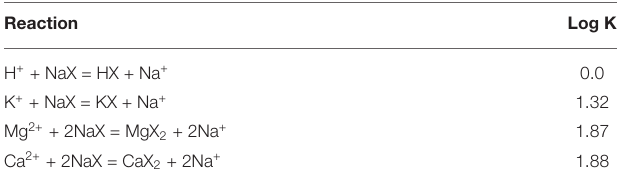
TABLE 3 | Cation exchange reactions and rate